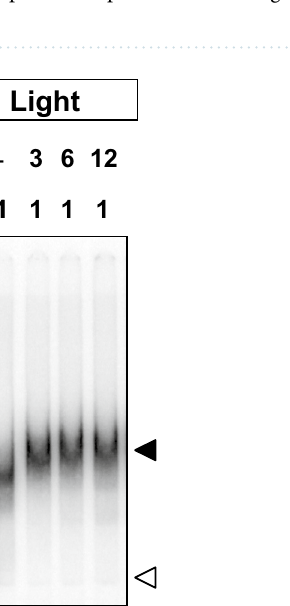
state (Fig. 6A and B), suggesting that PmlR2 and PmSB-LOV exist in a hexamer and trimer, respectively, in solution. When PmlR2 and PmSB-LOV were co-incubated in the dark, they were eluted as two major peaks (Fig. 6D). Each elution volume was almost identical to those of PmlR2 and PmSB-LOV. SDS-PAGE and silver staining confirmed that the former and latter peaks contained PmlR2 and PmSB-LOV, respectively. Thus, incubation in dark did not affect the interaction between PmSB-LOV and PmlR2. In contrast, illuminated mixtures of PmlR2